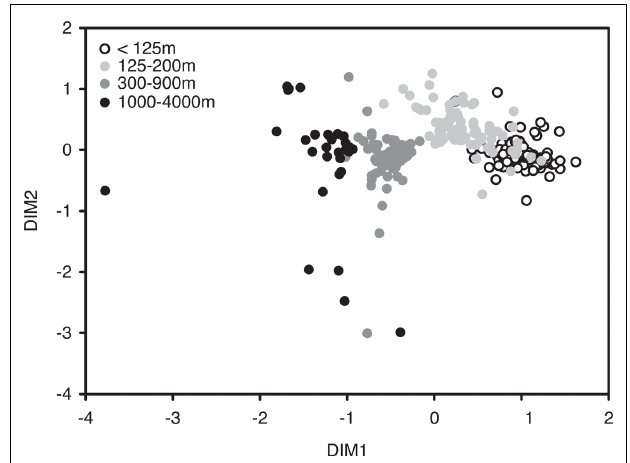
FIGURE 3 | Non-metric multidimensional scaling (NMS) of bacterial community structure based on aT-RFLP analysis of bacterial SSU rRNA genes amplified from bacterioplankton samples collected approximately monthly at StationALOHA from November 2004 to February 2008 ( n = 296; stress-value = 12.1)